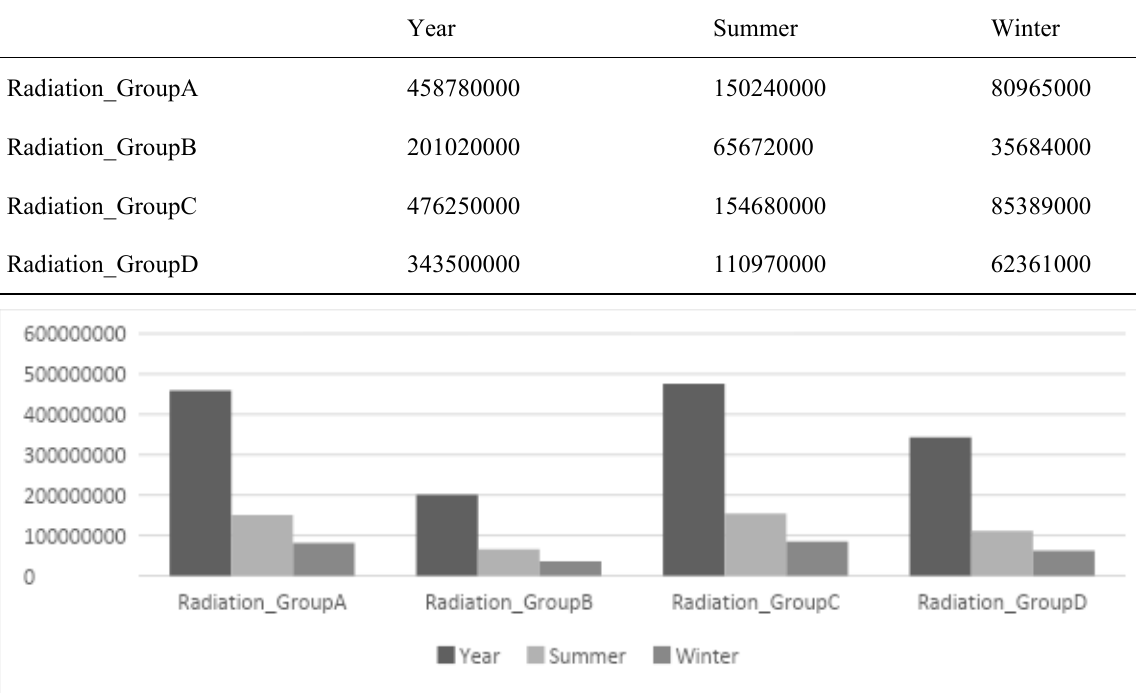
Figure 13- Diagram of changes in the amount of radiation in the four sub-neighborhoods of Farhangian, phase 1 by year and season (summer and